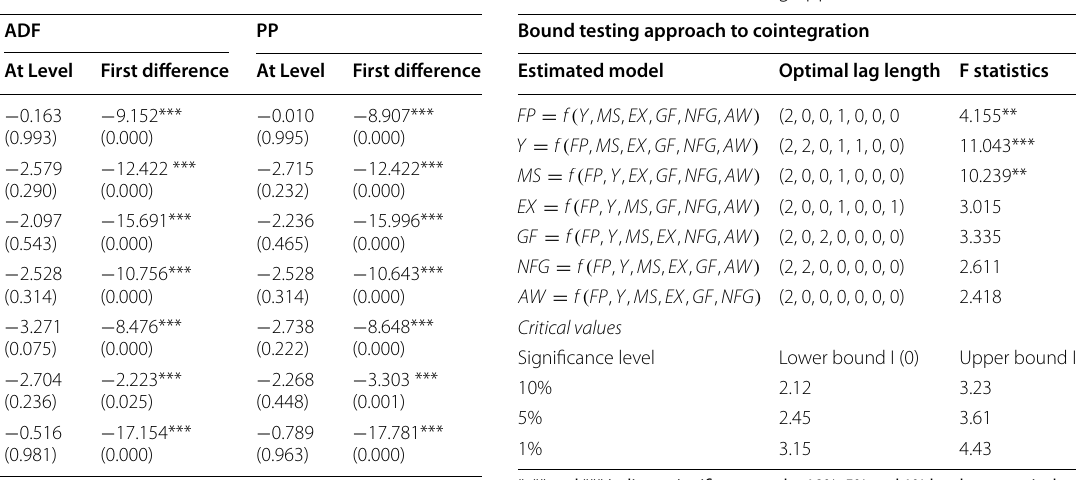
Table 3 Unit root test results Table 4 ARDL bounds testing